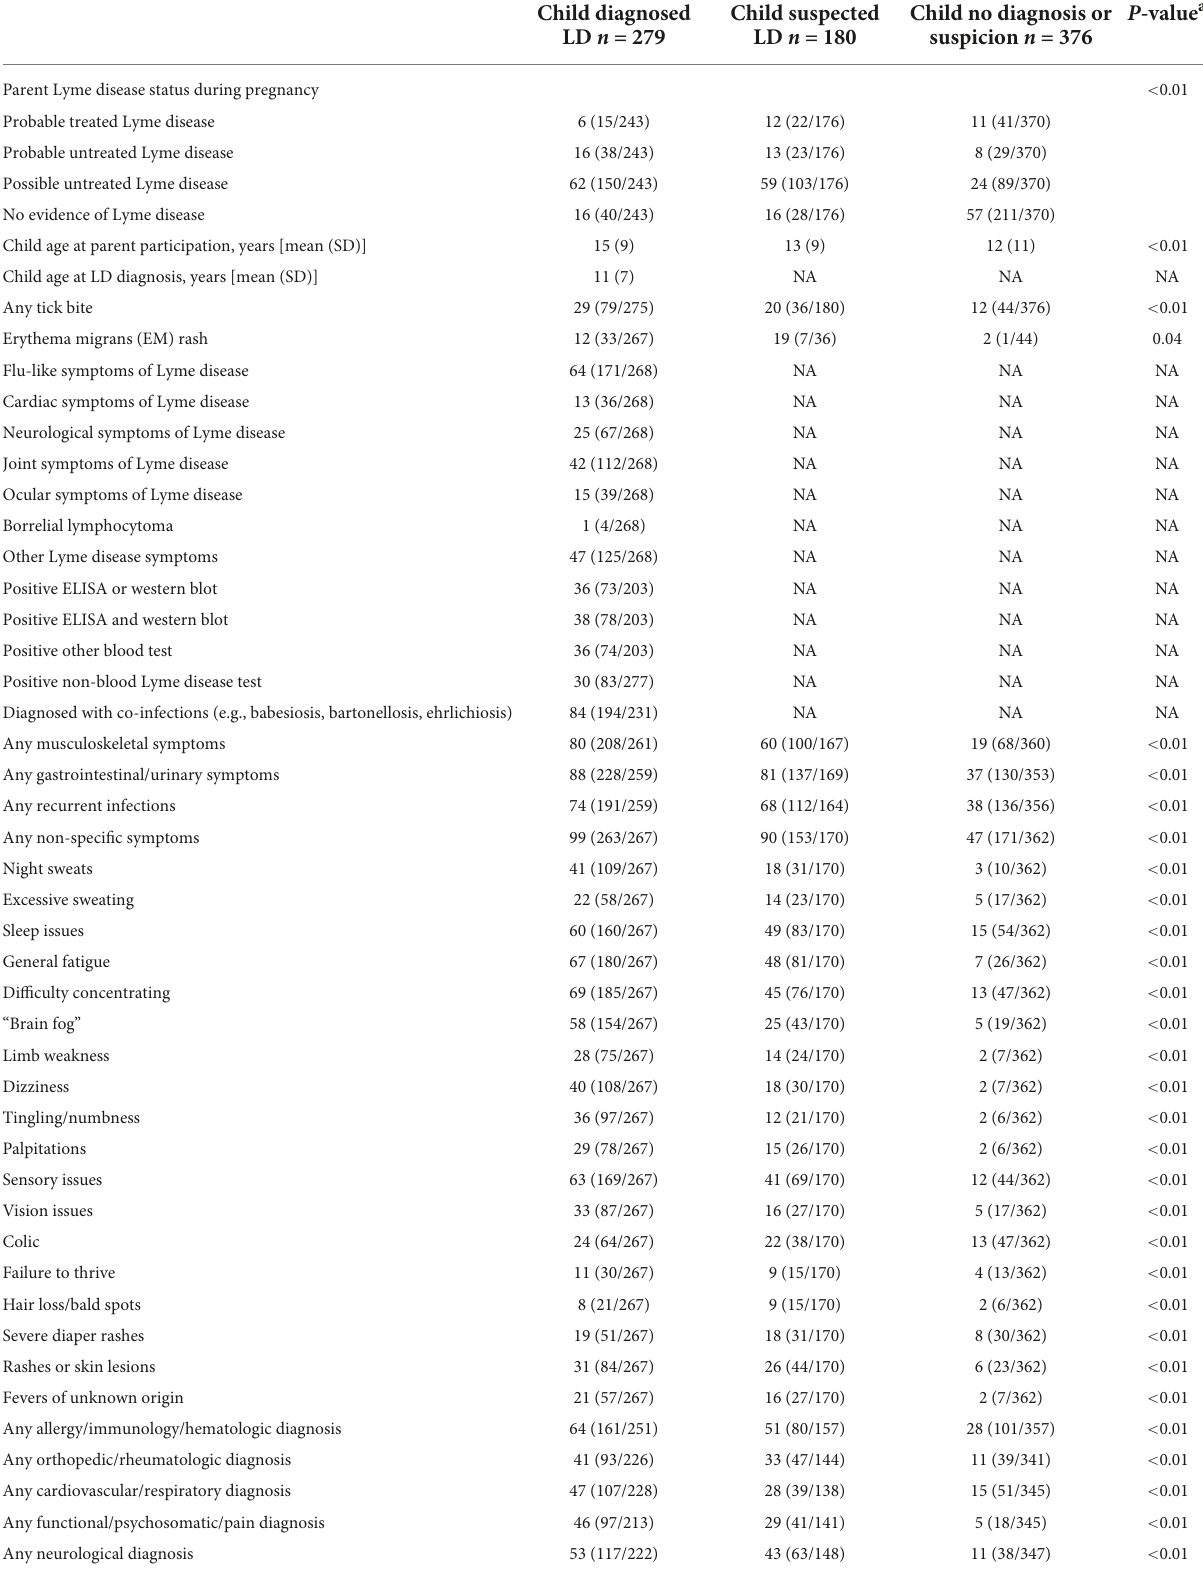
TABLE 8 Child outcomes by child LD